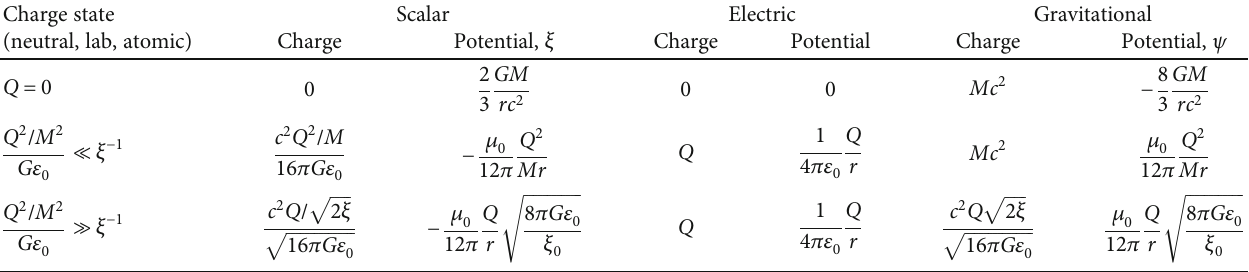
≡ ξ ð r Þ , ξ ⟶ 0 as r ⟶ 0 0 0 0